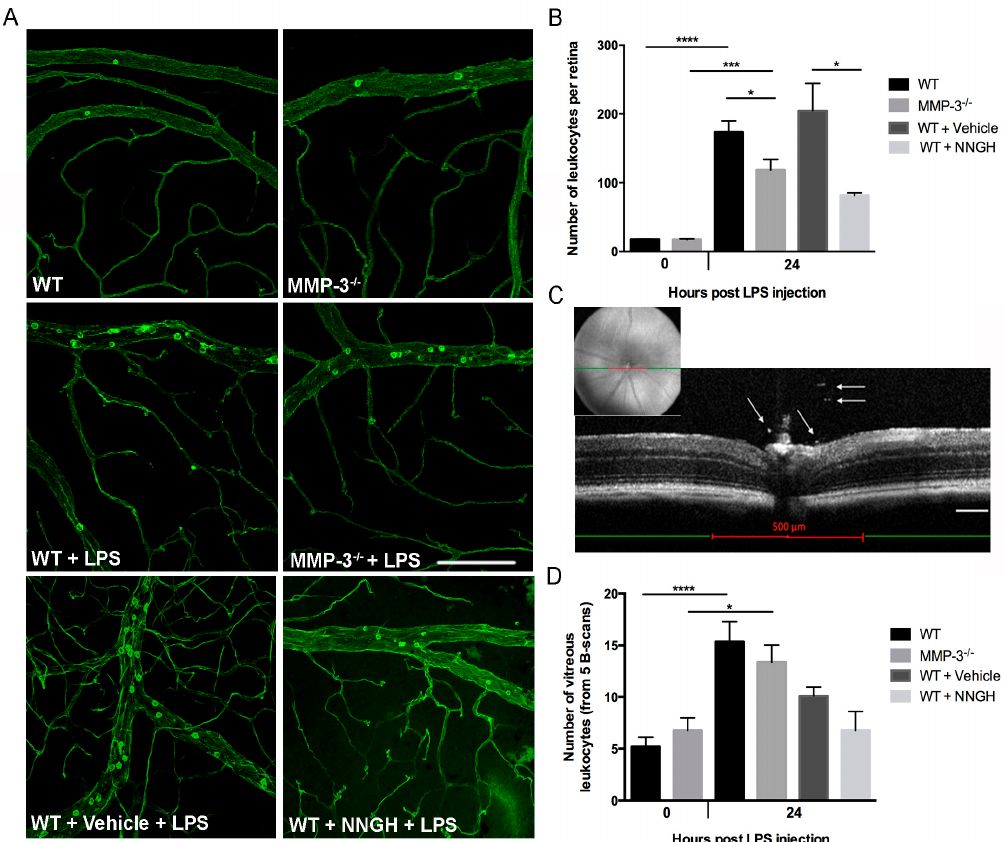
Figure 4. Impact of MMP-3 deficiency on leukocyte adhesion in the retinal vessels and on the amount of infiltrating leukocytes into the vitreous cavity during EIU. ( A ) EIU induces a prominent augmentation in the number of firmly adhering leukocytes at the retinal vessel wall as demonstrated in flatmounted retinas from WT and MMP-3 − / − mice at 24 hpi. However, leukocyte adhesion seems to be reduced in MMP-3 − / − animals. Similarly, the number of adherent leukocytes seems to be lower in NNGH-treated vs. vehicle-treated WT mice at 24 hpi; Scale bar: 100 µm; ( B ) Quantification of adherent retinal leukocytes in the arterioles and venules showed significantly less adherent leukocytes in EIU-treated MMP-3 − / − mice than in WT animals ( n ≥ 5). In addition, leukostasis was also suppressed after repeated intraperitoneal injections of the MMP-3 inhibitor NNGH, compared to vehicle (5% DMSO)-injected eyes ( n ≥ 4). * p ≤ 0.05, *** p ≤ 0.001 and **** p ≤ 0.0001; ( C ) OCT measurements at 24 hpi were assessed to evaluate the number of leukocytes infiltrating into the vitreous cavity in healthy and EIU MMP-3 − / − , WT and NNGH- or vehicle-treated WT mice. Infiltrating leukocytes (as indicated on the single B-scan by arrows) were manually counted on five single B-scan images over a distance of 500 µm (red line), centered on the optic disc using fundus images: one B-scan image at the optic nerve head and four images at 50 µm intervals from the optic nerve head (two anterior and two posterior). Scale bar: 100 µm; ( D ) The number of infiltrating leukocytes in the vitreous significantly increased in both WT and MMP-3 − / − mice at 24 hpi. Interestingly, MMP-3 deficiency, either via genetic or pharmacological manipulation, slightly reduced the number of infiltrating leukocytes as compared to (vehicle-treated) WT eyes ( n ≥ 5). Data are shown as mean ± SEM, * p ≤ 0.05, **** p ≤ 0.0001.